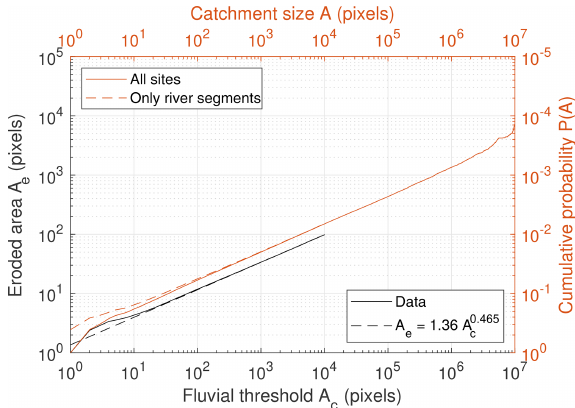
Figure 7. Black axes: eroded area as a function of the fluvial thresh- old. Colored axes: cumulative distribution of the catchment sizes.